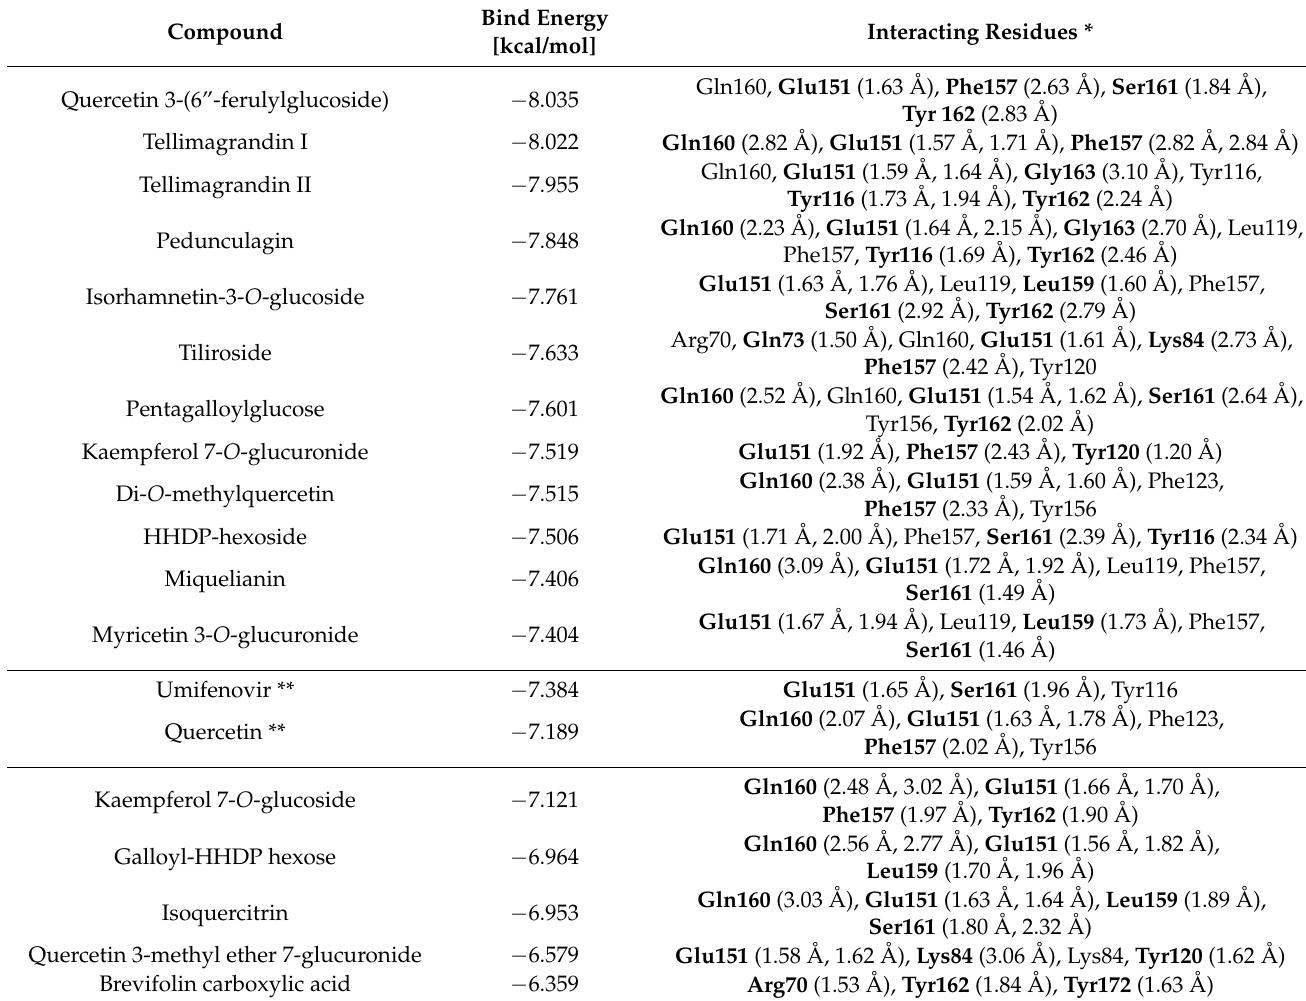
Table 2. Molecular docking simulation results of A. viridiflora constituents and positive controls against wild type S-glycoprotein target (PDB ID: